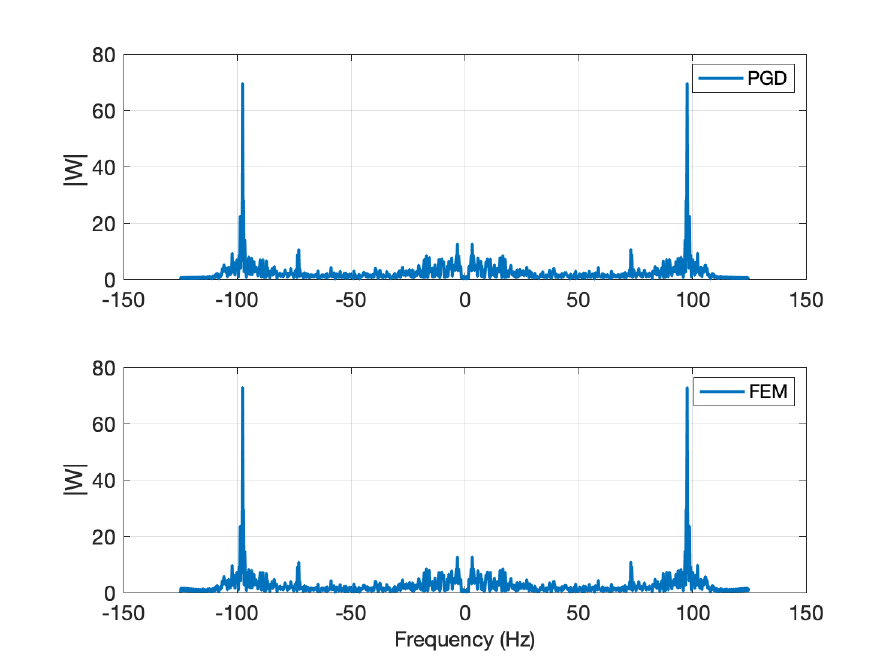
Figure 11. Displacement amplitude W versus frequency at top of the top